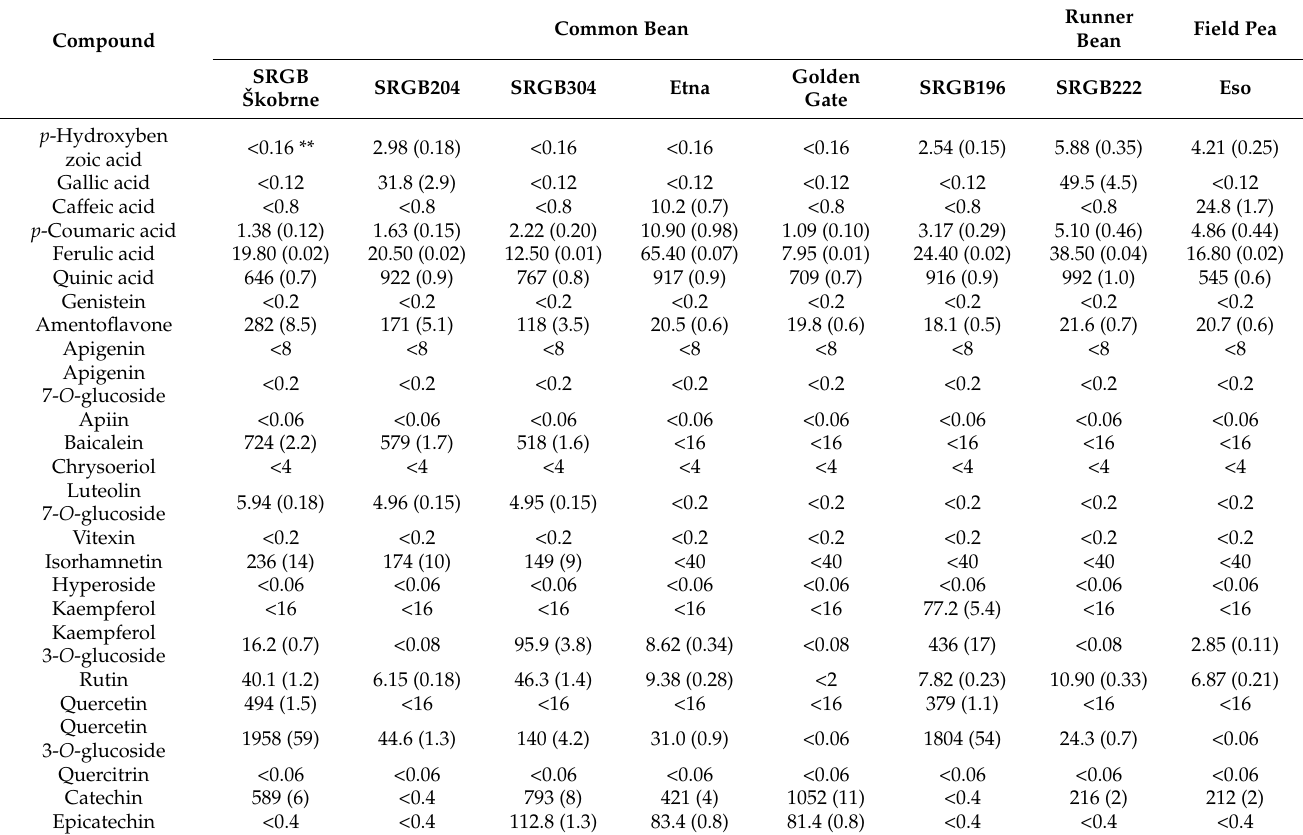
Table 2. Quantification of phenolic compounds ( µ g/g dry weight (DW)) in common bean, runner bean and field pea seeds